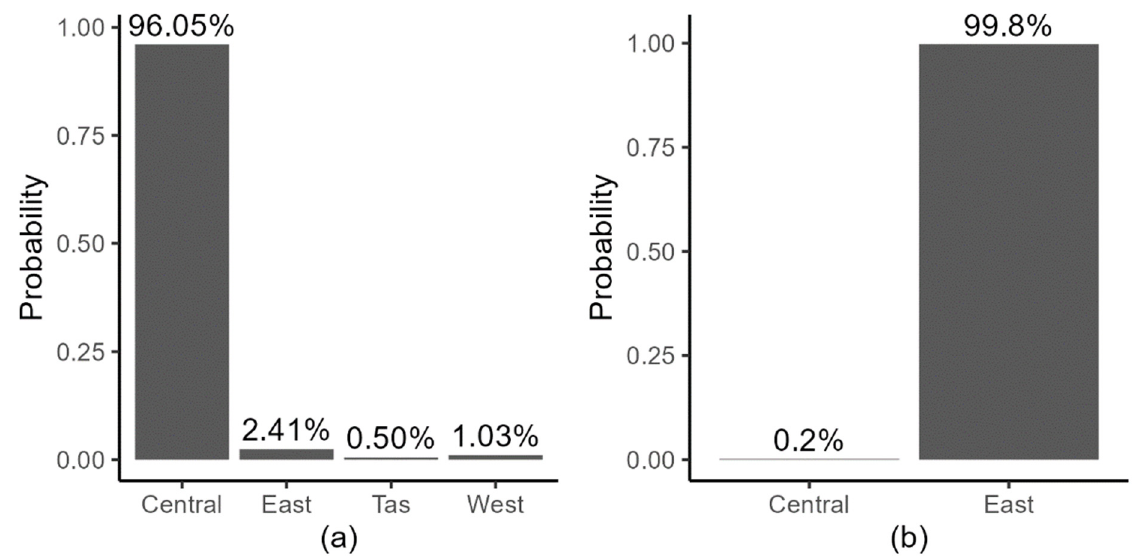
Figure 7. Posterior probability of the root location for RHDV1 ( a ) and RHDV2 ( b ) across the possible demes considered by the analysis. Note that for RHDV2, the Western region and Tasmania were not included in the credible intervals.